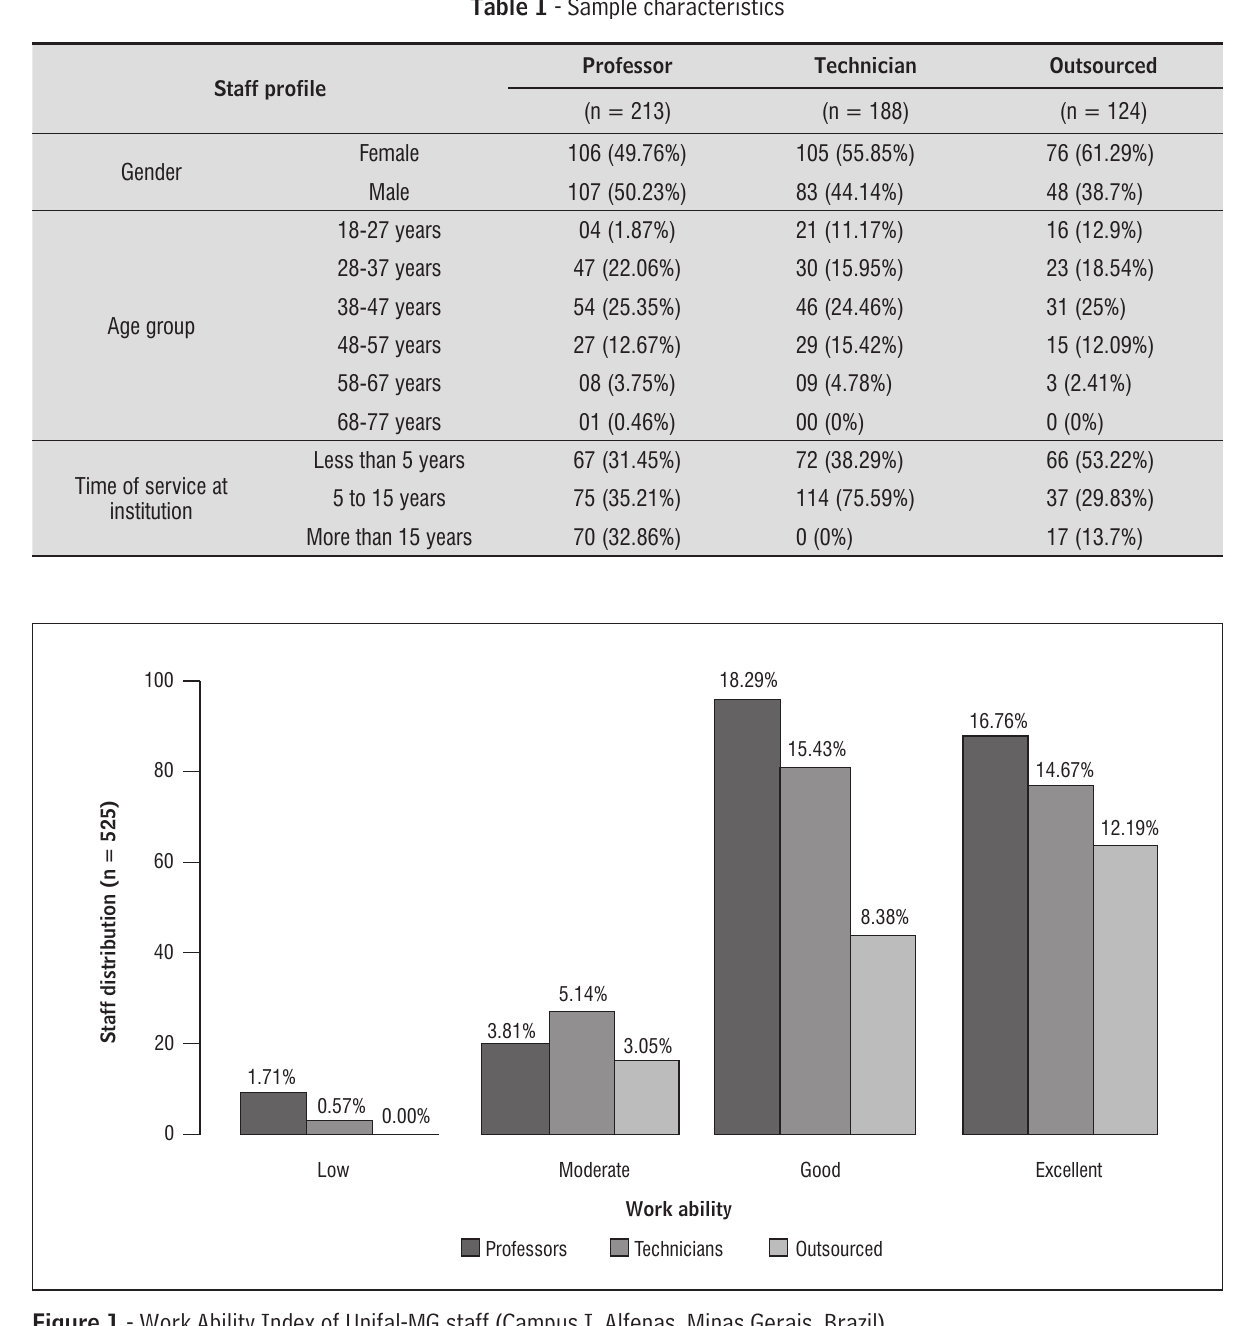
Figure 1 - Work Ability Index of Unifal-MG staff (Campus I, Alfenas, Minas Gerais,